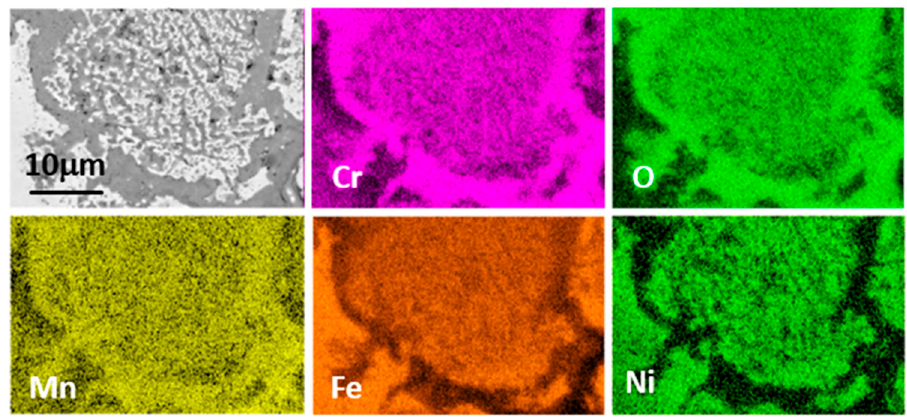
Figure 11. FESEM cross section of internal oxidation zoned formed on HT347HFG exposed to steam at 700 °C under atmospheric pressure after 3000 h.